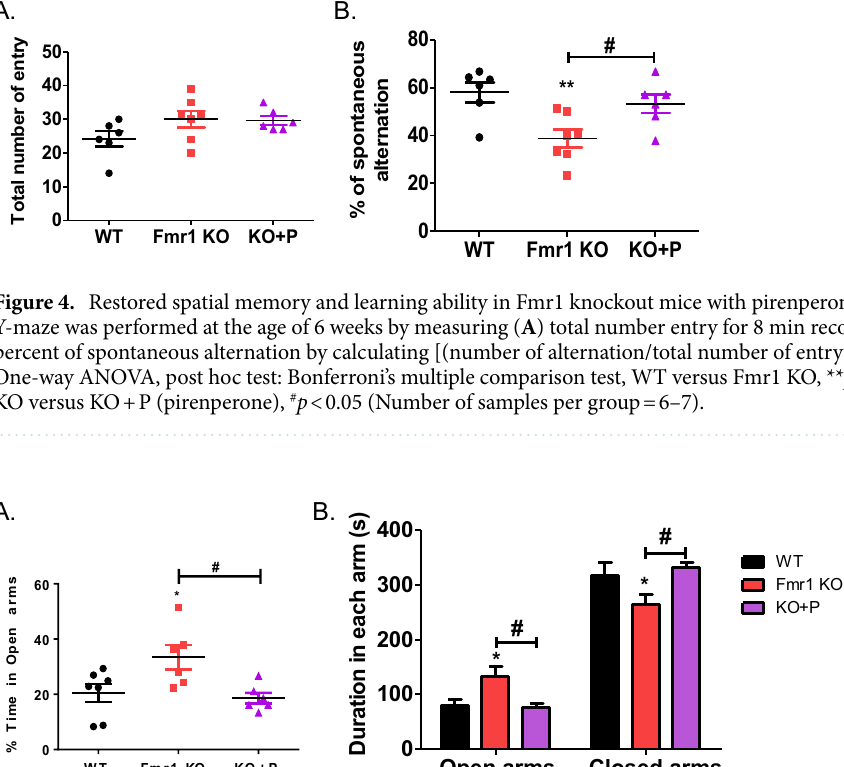
Figure 5. Level of impulsivity was normalized after pirenperone treatment. Elevated plus-maze was performed at the age of 6 weeks. ( A ) The duration of staying at both open and closed arms were measured and the percent time in open arms was calculated using the following formula [(duration in open arms)/(duration in both open and closed arms) × 100]. One-way ANOVA, post hoc test: Bonferroni’s multiple comparison test, WT versus Fmr1 KO, * p < 0.05, Fmr1 KO versus KO + P (pirenperone), # p < 0.05. ( B ) The frequency of entering each arm by the group (Number of samples per group =